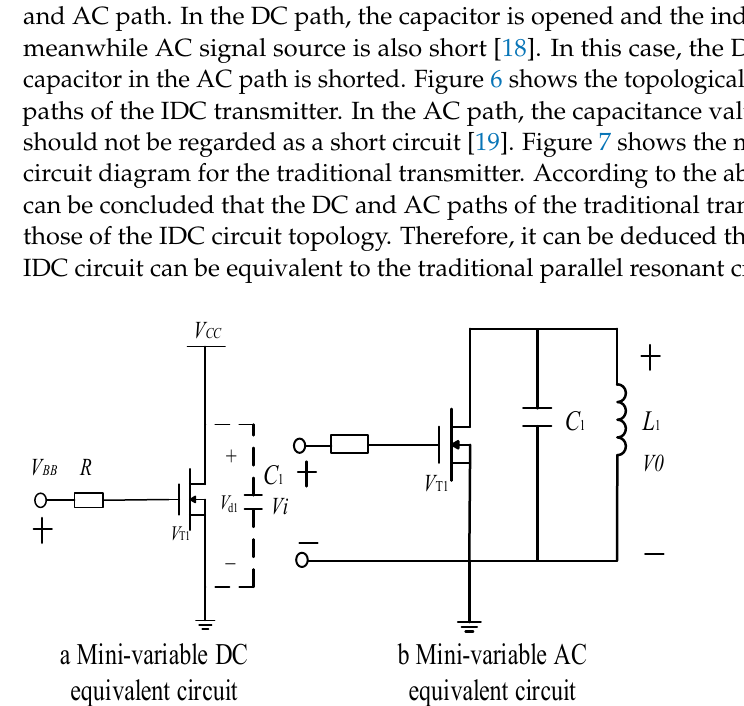
Figure 6. Micro-variant equivalent circuit diagram for IDC transmitter.